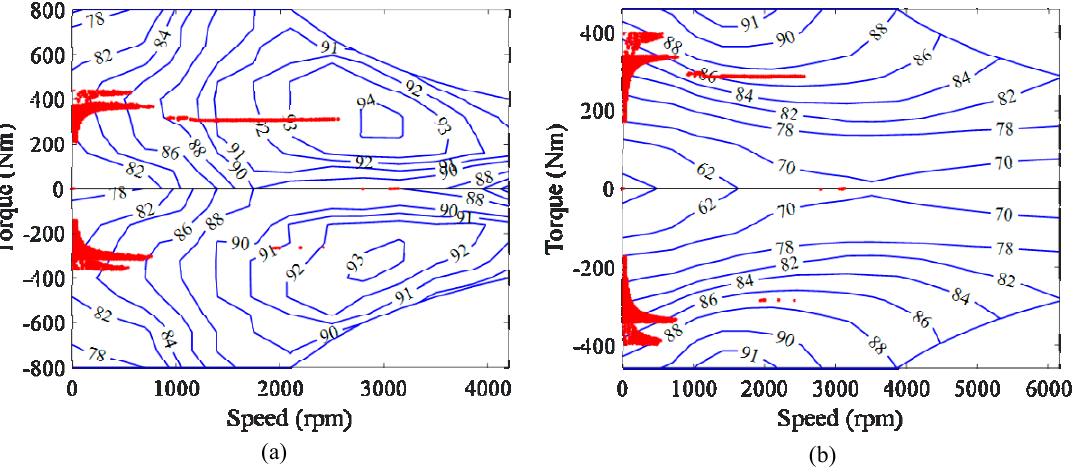
Figure 9. CEM and CHM working points in IHV. ( a ) CEM. ( b ) CHM.